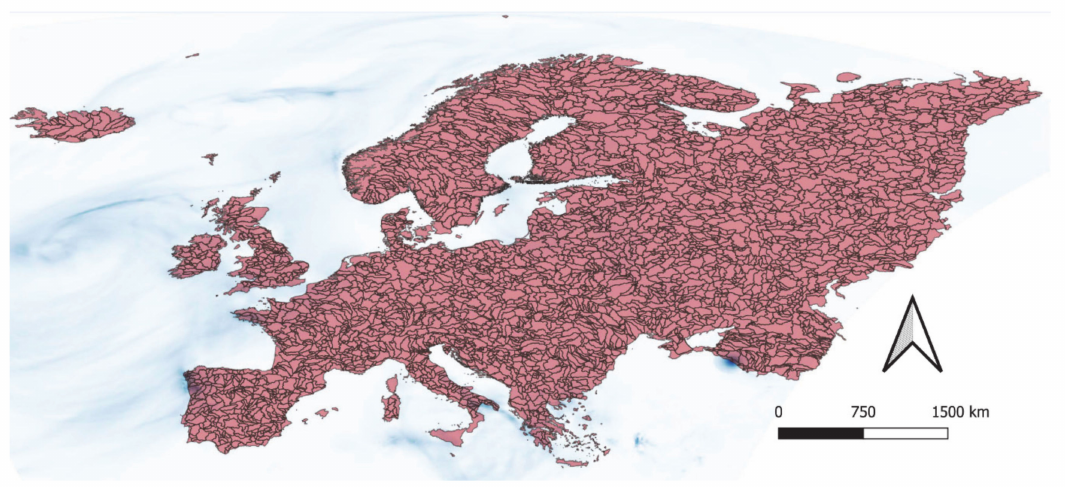
Figure 1. Example of the UERRA regional reanalysis total precipitation data for 1 January 2001 and HydroSHEDS catchment polygons at the 7th Pfafstetter